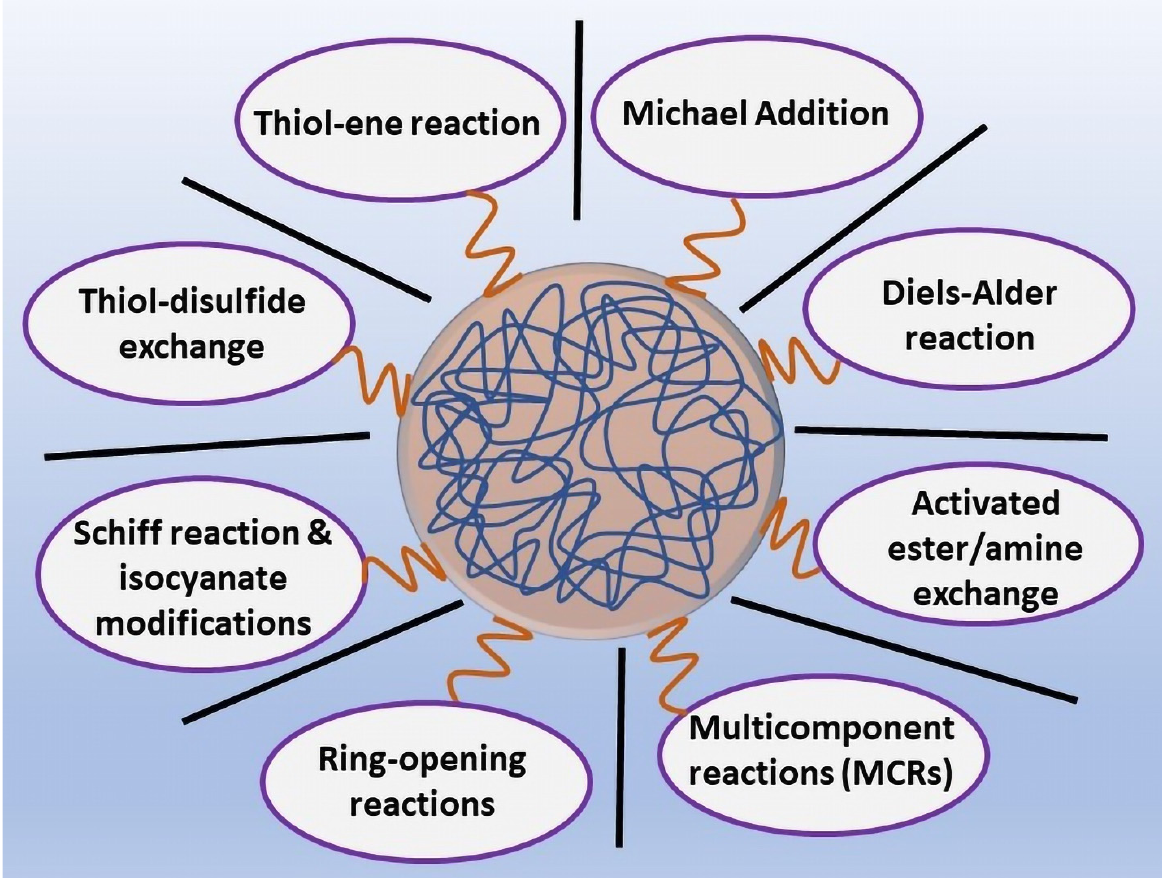
Figure 1. Various functionalization strategies involved in the synthesis of functionalized NGs.